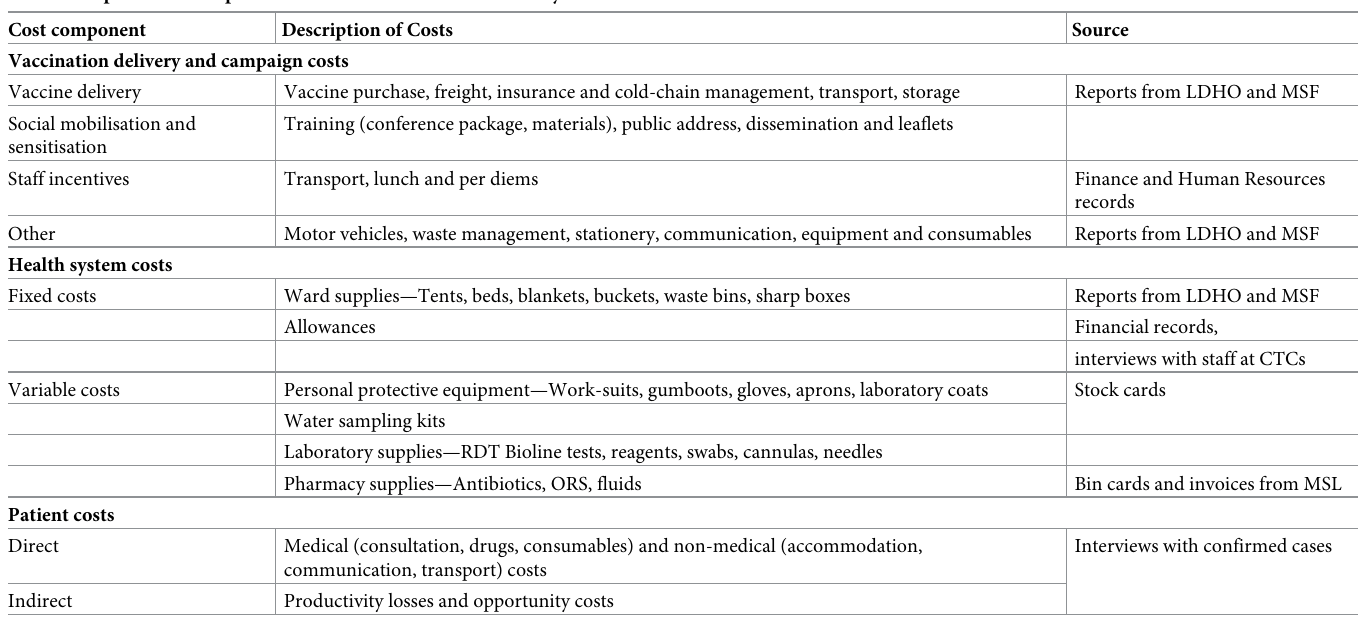
Table 1. Expenditure components and sources of data for health system and household